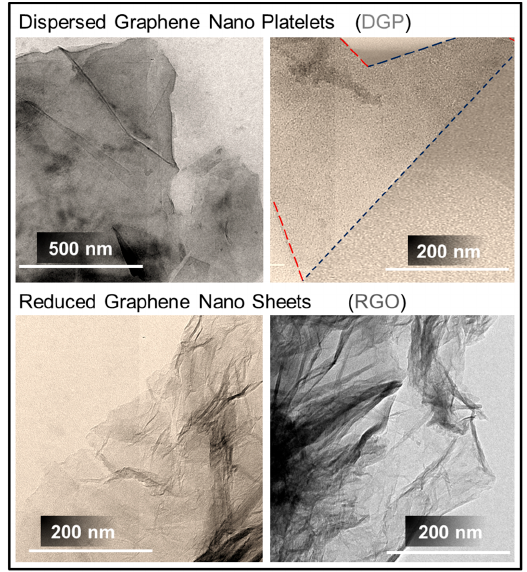
Figure 4. High resolution transmission electron microscope images of graphene nanosheets obtained with the aqueous phase dispersion technique and the Hummer method.